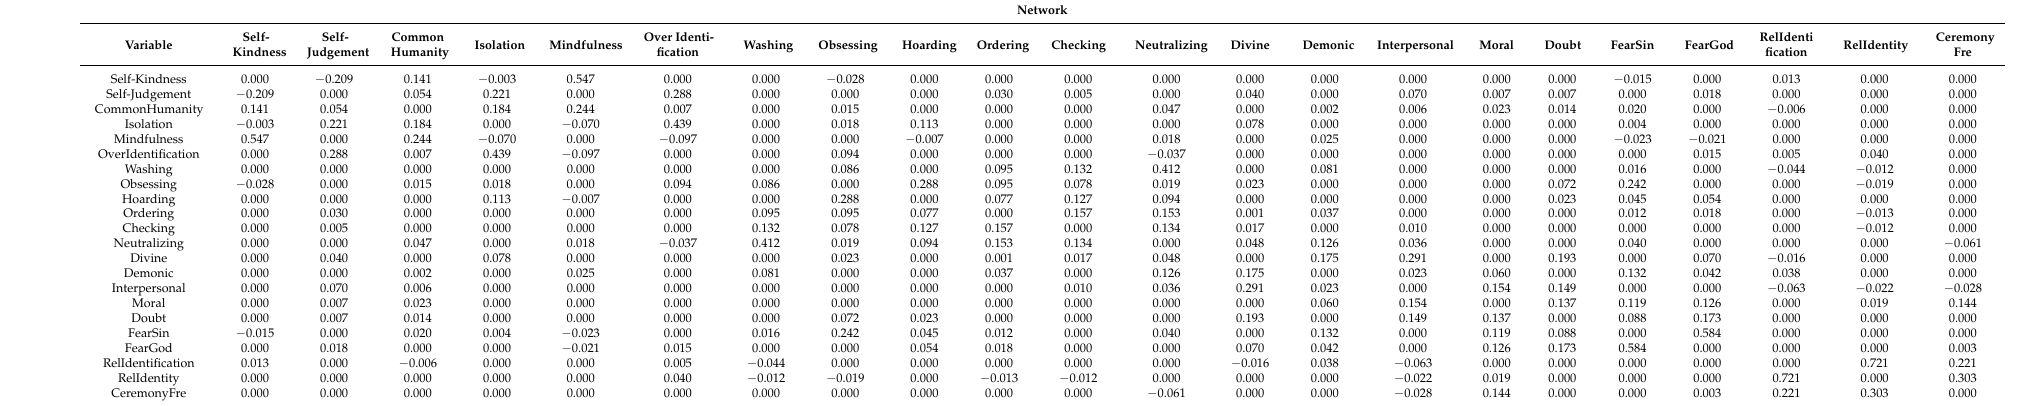
Table A1. Edge-weights of the network